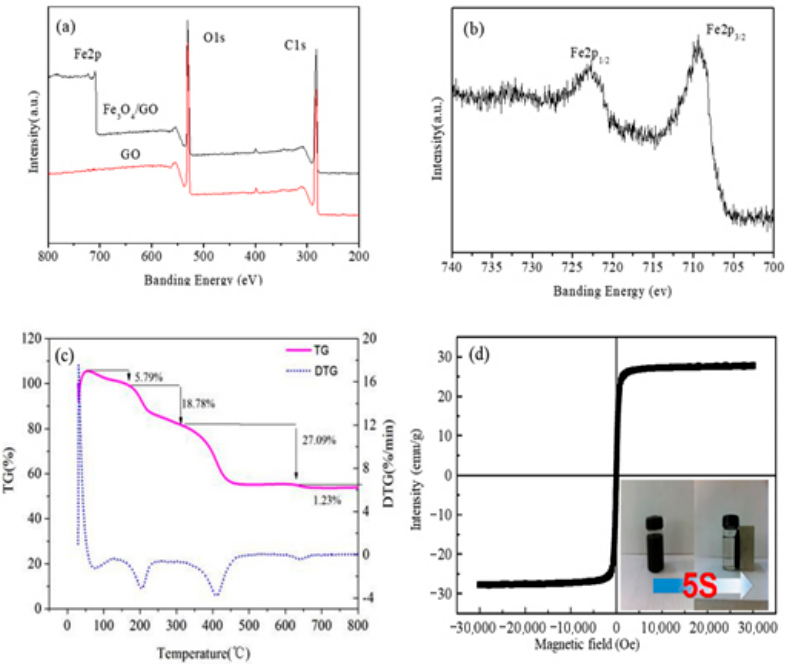
Figure 4. ( a ) XPS survey spectra of rGO/Fe 3 O 4 . ( b ) High-resolution XPS spectra of Fe 2p ; ( c ) curves of TG and DTG for rGO/Fe 3 O 4 in air atmosphere; ( d ) Magnetization curves of rGO/Fe 3 O 4 . Photographic photos of rGO/Fe 3 O 4 ( left ) and its behavior in a magnetic field are shown in the inset ( right ). Table 1 shows the BET surface areas of the as-obtained materials. According to the BET The percentage of each component in rGO/Fe 3 O 4 composite was determined analysis, the addition of Fe 3 O 4 decreased the BET surface areas to 522.134 m 2 /g, compared with GO (635.21 m 2 /g). Although the reduction of rGO will increase the surface areas, the decrease caused by inclusion of FeO 4 which increases the adsorption site occupancy. Table 1. BET computation outcomes for GO and rGO/Fe 3 O 4 .